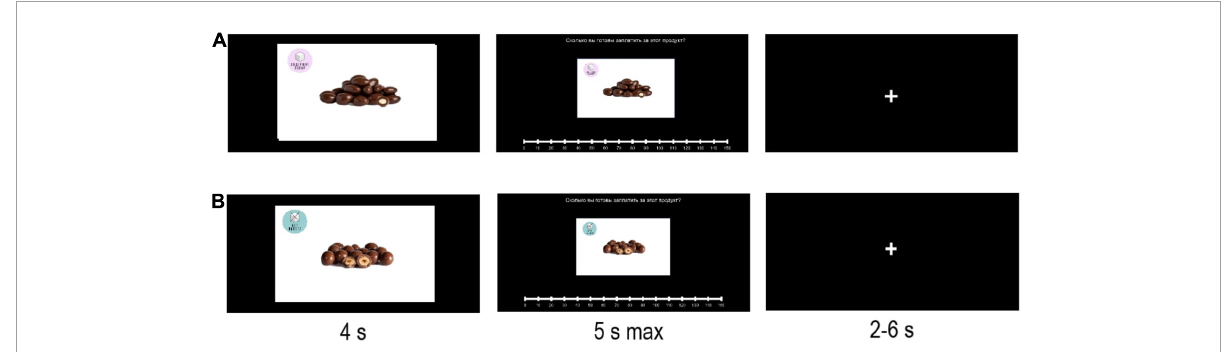
FIGURE1 Bidding task. Sample trial with food labeled as sugar-containing (A) and sample trial with food labeled as sugar-free (B) . At the beginning of each trial, a product was displayed for 4 s. Next, a message was displayed at the top of the screen “How much does this product worth to you?” as in (66). Participants had 5 s to indicate their WTP for this product, using a discrete slider (0–150 MU, with an increment of 10 MU). Last, a fixation cross was shown (2–6 s) and the next trial began.